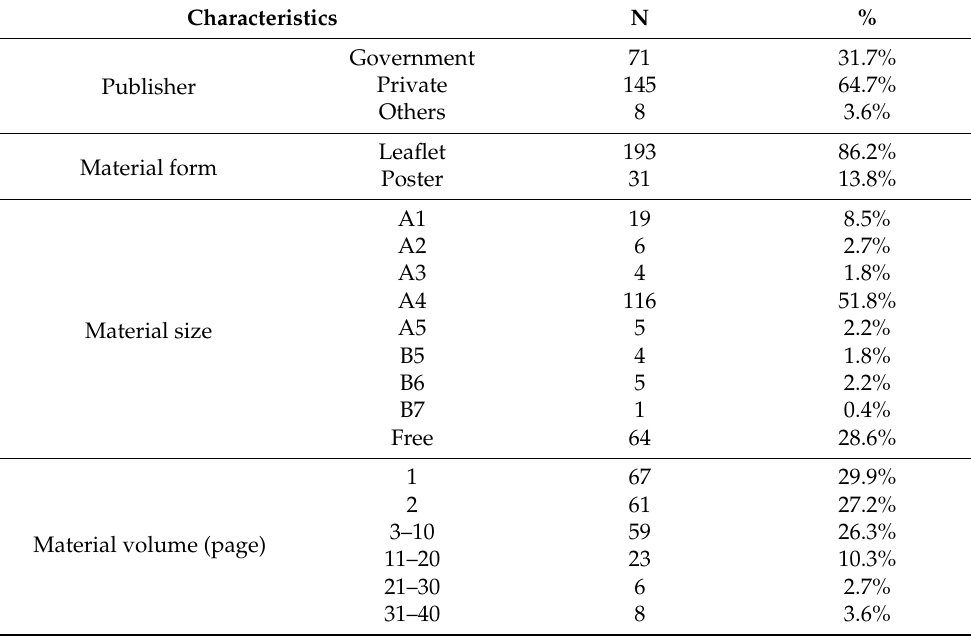
Table 1. Sample characteristics ( N =